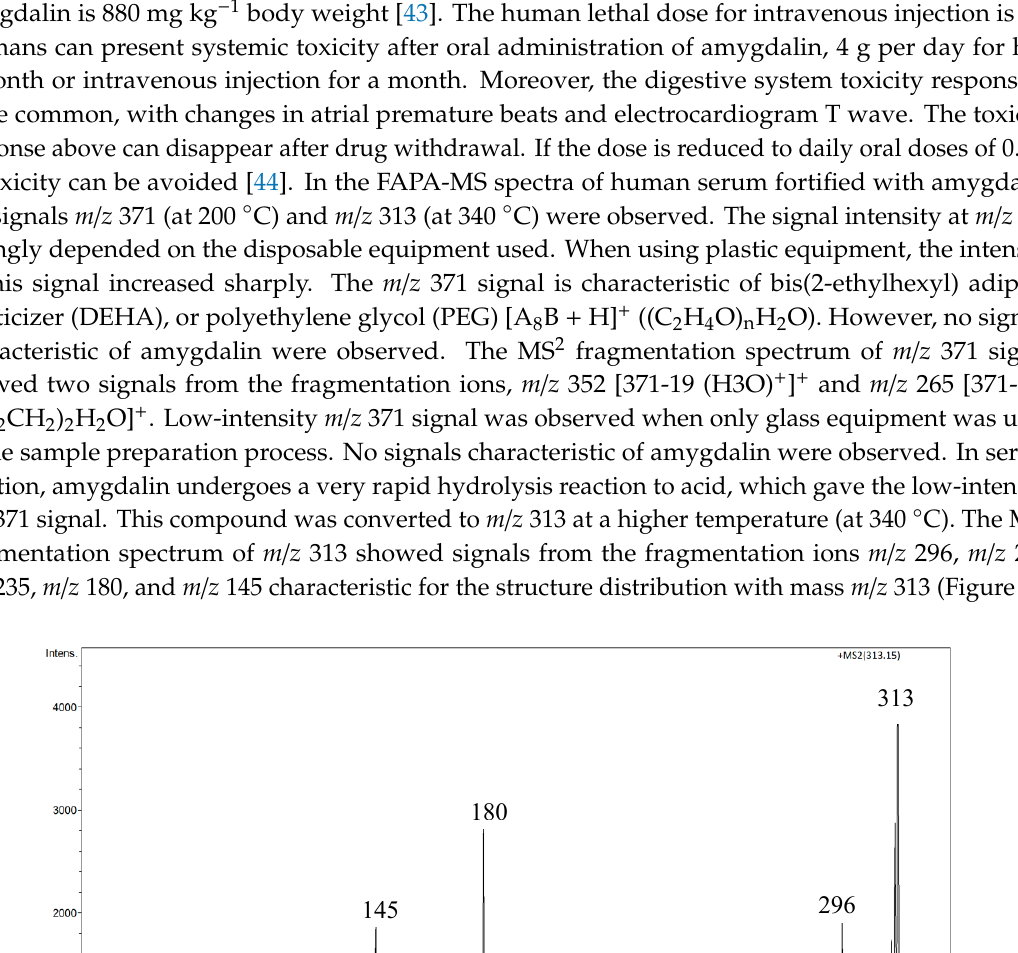
Figure 20. FAPA-MS spectrum of amygdalin in human serum at 200 °C.